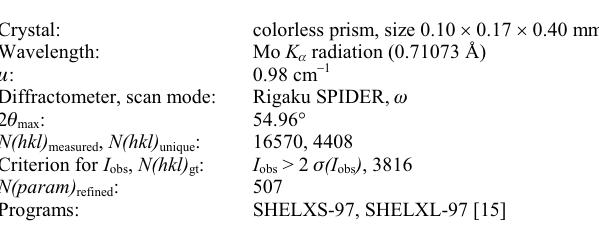
Table 1. Data collection and